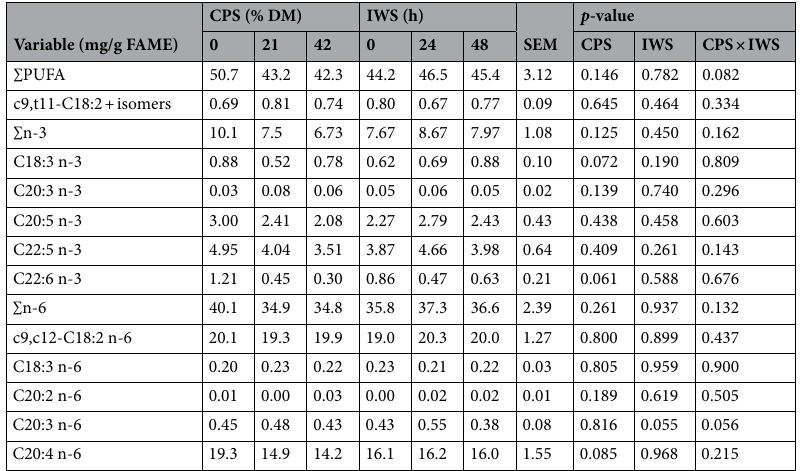
Table 8. Polyunsaturated fatty acids (PUFA) from Longissimus lumborum muscle of goats fed with cactus pear silage (CPS) and submitted to intermittent water supply (IWS). a,b Means within rows with different letter superscripts differ by Tukey test ( p < 0.05).